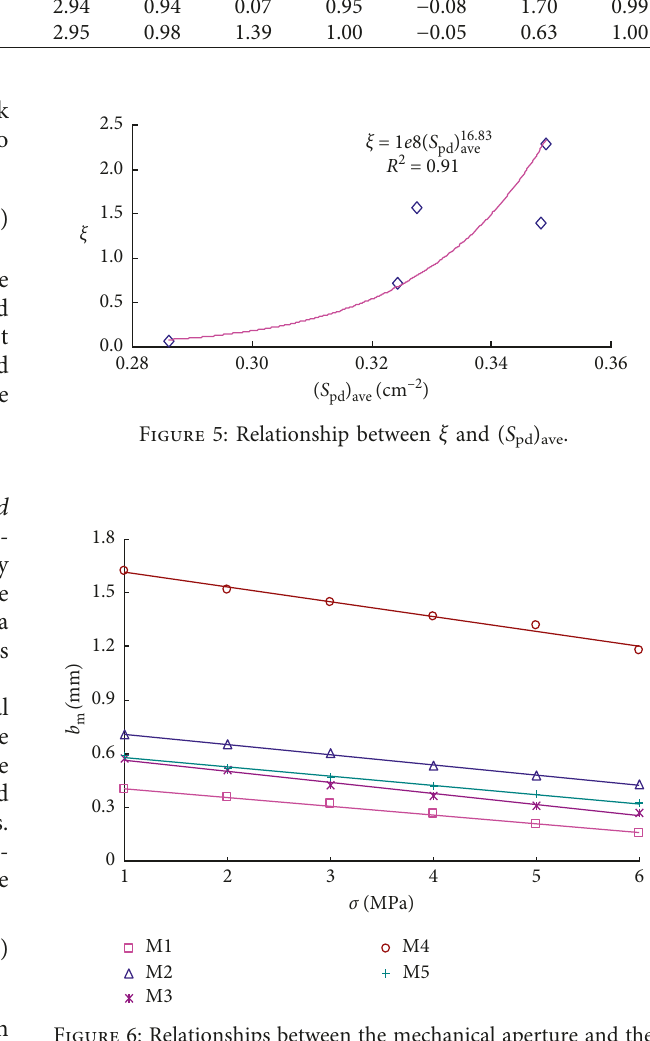
Figure 6: Relationships between the mechanical aperture and the normal